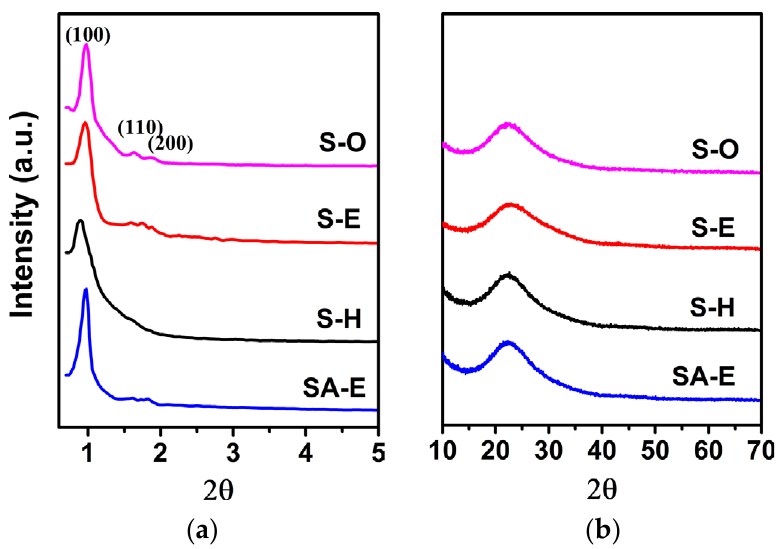
wide-angle XRD analysis (Figure 3b).